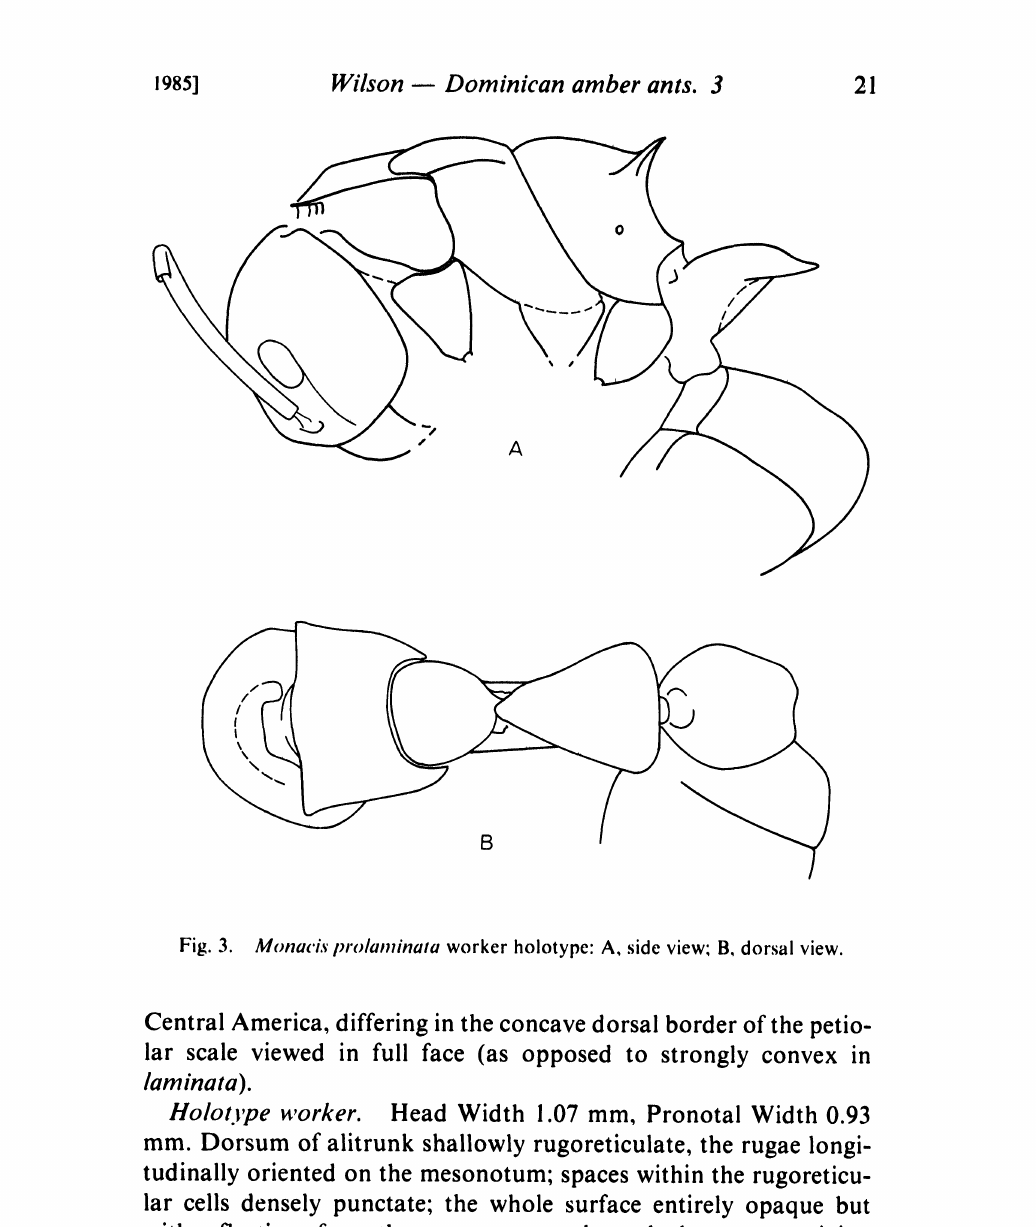
Fig. 3. Monacis prolaminata worker holotype: A, side view; B, dorsal view. Central America, differing in the concave dorsal border of the petio- lar scale viewed in full face (as opposed to strongly convex in